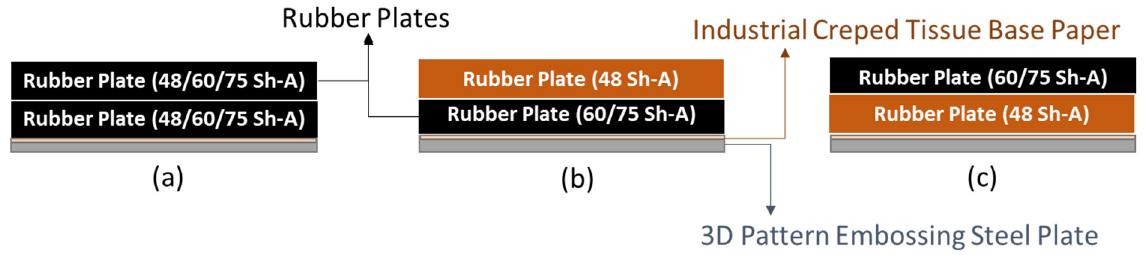
Figure 3. Schematic of the embossing process with different rubber plate hardness configurations: ( a ) configuration 1; ( b ) configuration 2; and ( c ) configuration 3.